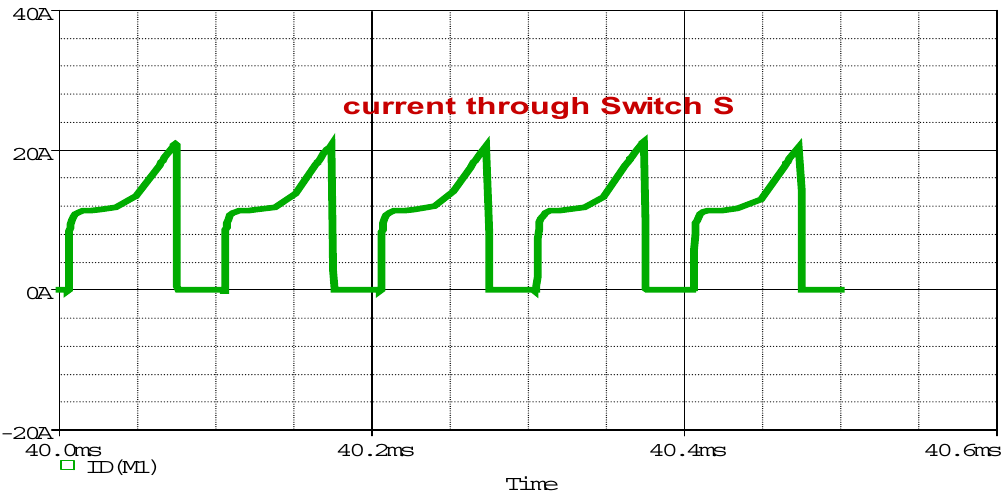
Figure 27. Current through switch “s” of the high-gain boost converter [7].